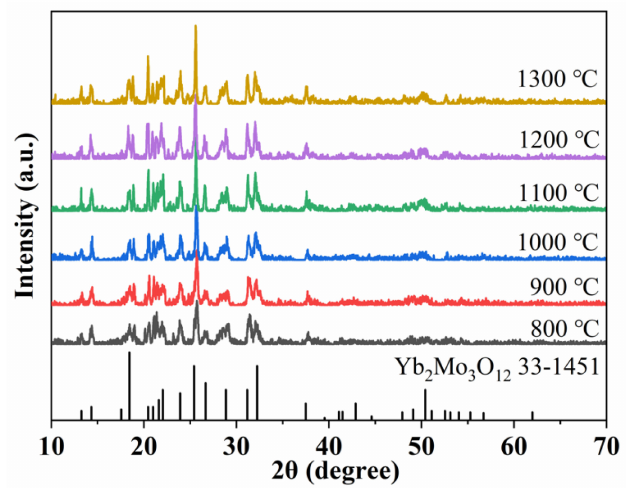
Figure 1. Preparation of temperature-dependent XRD patterns of Tb 3+ -doped Lu 2 W 3 O 12 and reference